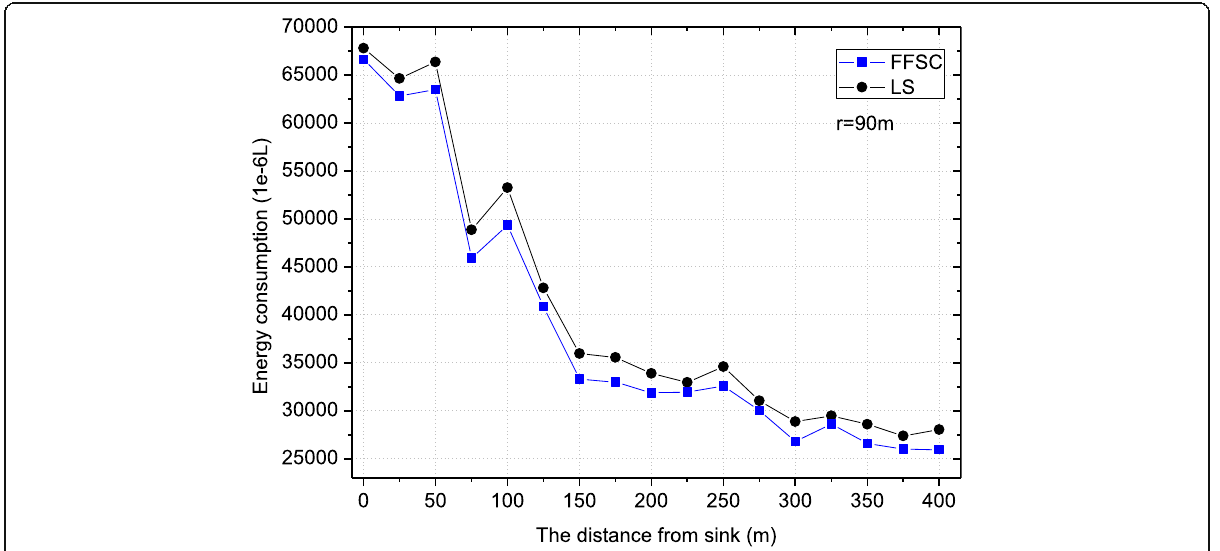
Fig. 14 The energy consumption under different distance from sink